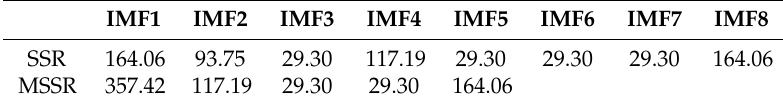
Table 3. The experimental results of inner race of motor bearing.